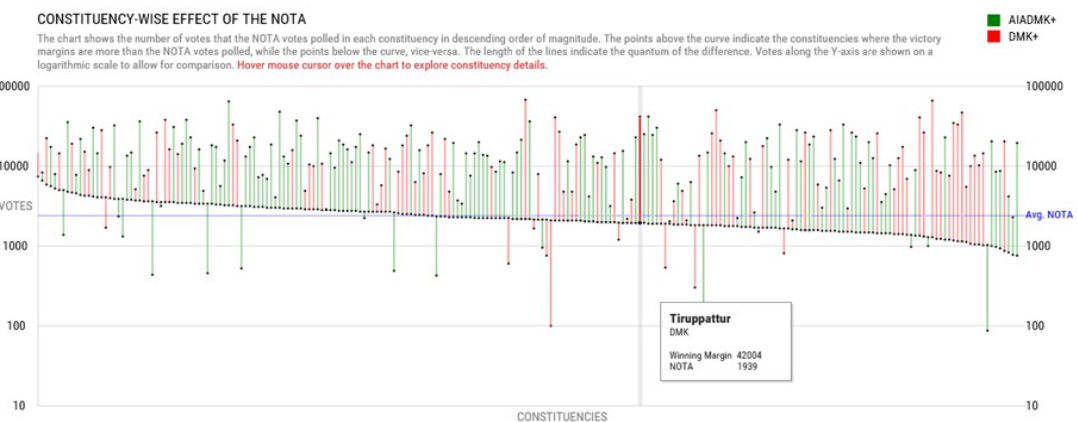
As per the common human mind set, we are more interested in optima points in the data. So, graphs are arranged in a way so that constituencies are sorted in descending order of magnitude of votes polled for NOTA, PMK or Third Front respectively. The lines above this curve indicate the constituencies where the victory margins are more than the votes polled for NOTA, PMK or Third Front, while the points below the curve, vice-versa. The average line plotted represents